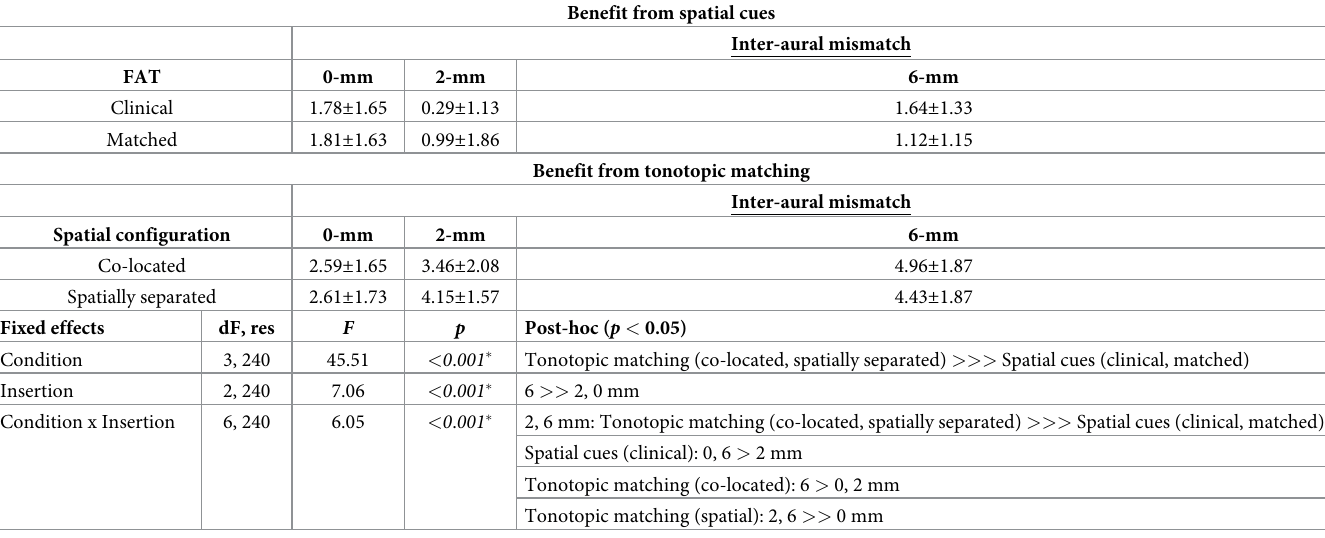
Table 3. Improvement in SRTs due to spatial cues (co-located–spatially separated) or tonotopic matching (clinical–matched), as a function of inter-aural mismatch. Top: Improvement in SRTs (mean ± standard deviation) due to spatial cues with the clinical or matched FAT, or due to tonotopic matching with co-located or spatially separated target and masker speech. Bottom: Results from LMM analysis of the SRT improvement